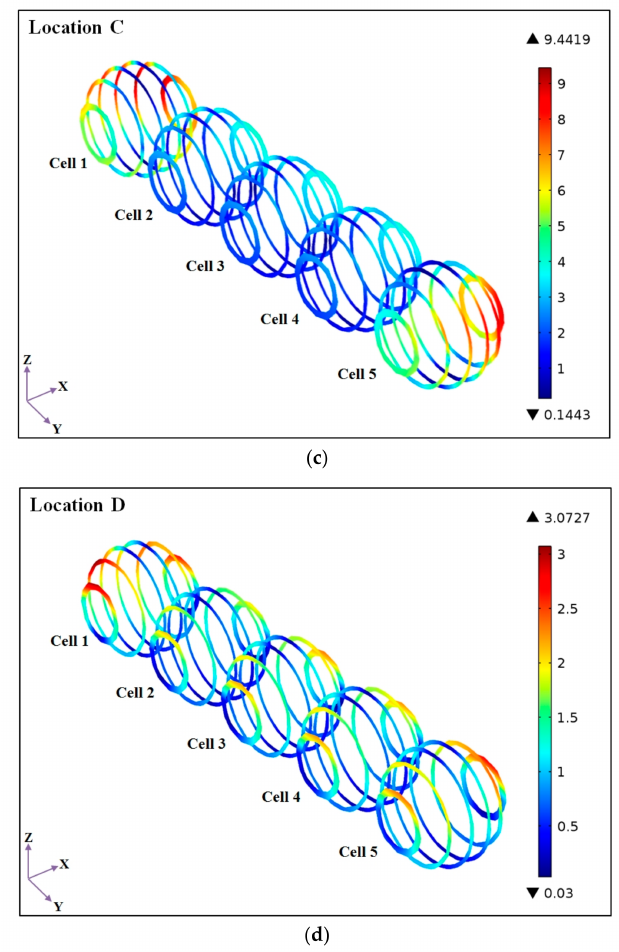
Figure 5. Contour plots of microalgal cell wall deformation (nm) for a raceway pond with AR = 10 at a water depth of 0.2 m and rotational speed of 20 (rpm). ( a ) location A ; ( b ) location B ; ( c ) location C and ( d ) location D